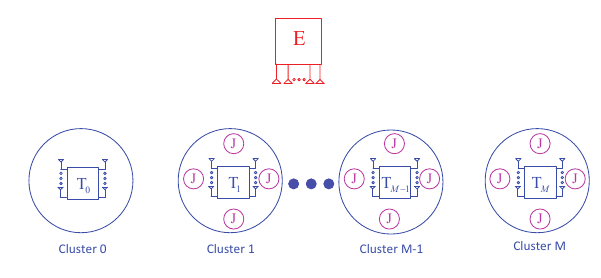
Figure 1. System model of the proposed harvest-to-jam based secure multi-hop cluster MIMO